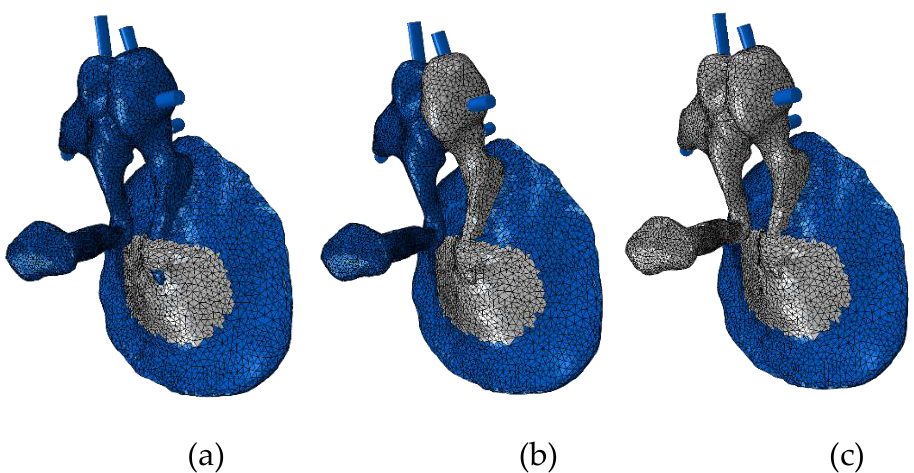
Figure 3. Eardrum and ossicles evidencing the tympanosclerotic plaques (in grey): ( a ) only in the eardrum; ( b ) in the eardrum and malleus; ( c ) in the eardrum and 3 ossicles.